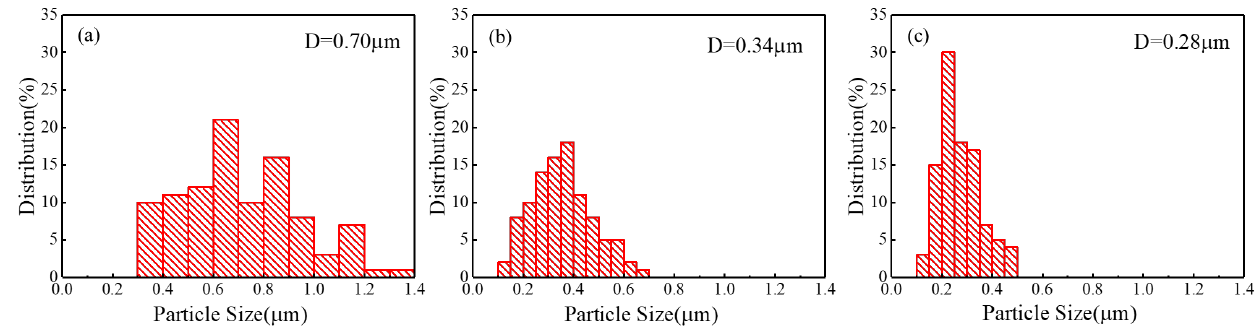
Figure 4. Size distribution of dispersed phase at stationary melting for 7 min: ( a ) LC2/LA(70/30); ( b ) LC4/LA(70/30); ( c ) LC8/LA(70/30).